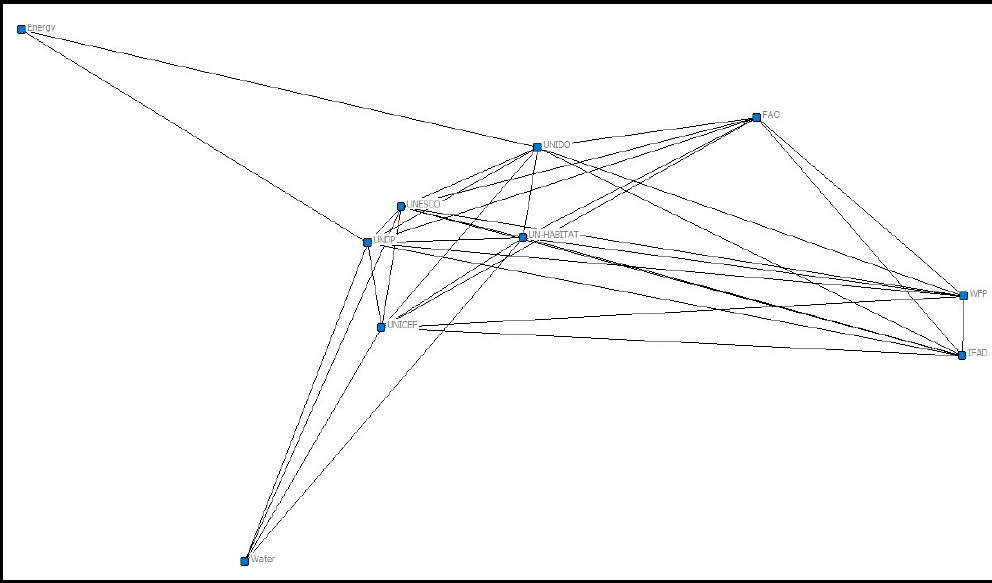
Figure 3. Organizations—FEW network.